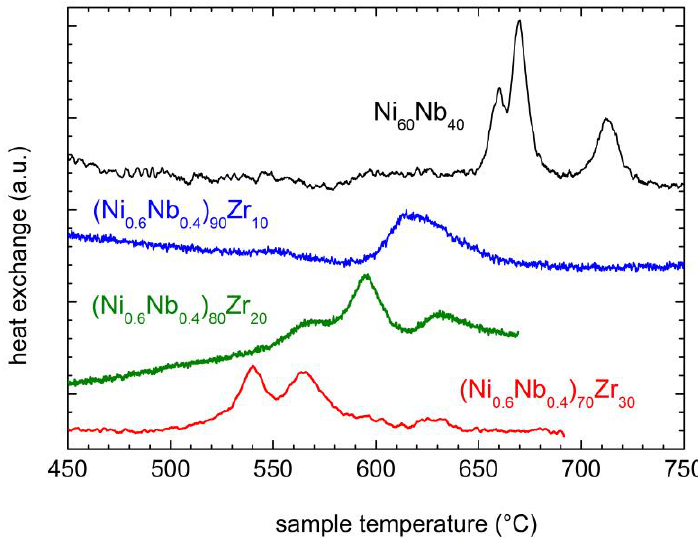
Figure 1. DTA curves of samples (Ni 0.6 Nb 0.4 ) 100−x Zr x for x = 0, 10, 20, and 30, measured with a temperature rate of 10 °C/min.